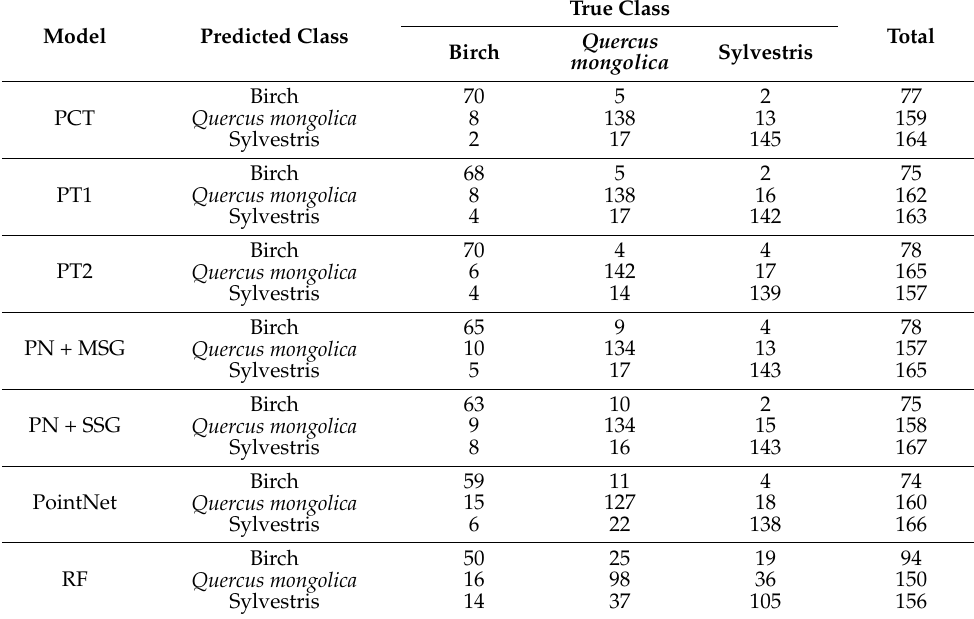
Table 3. The confusion matrix of detailed classification results of each algorithm on test set. Table 4. Comparison of classification accuracy of seven models.